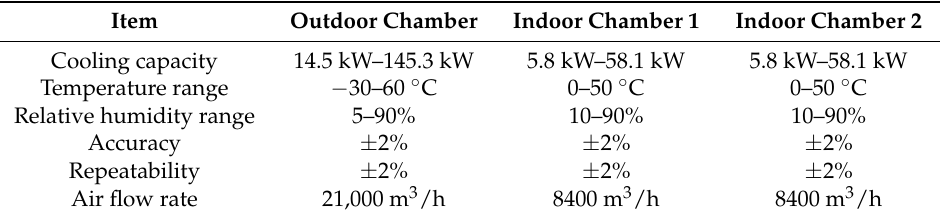
Table 1. The specification of Multicalorimeter.